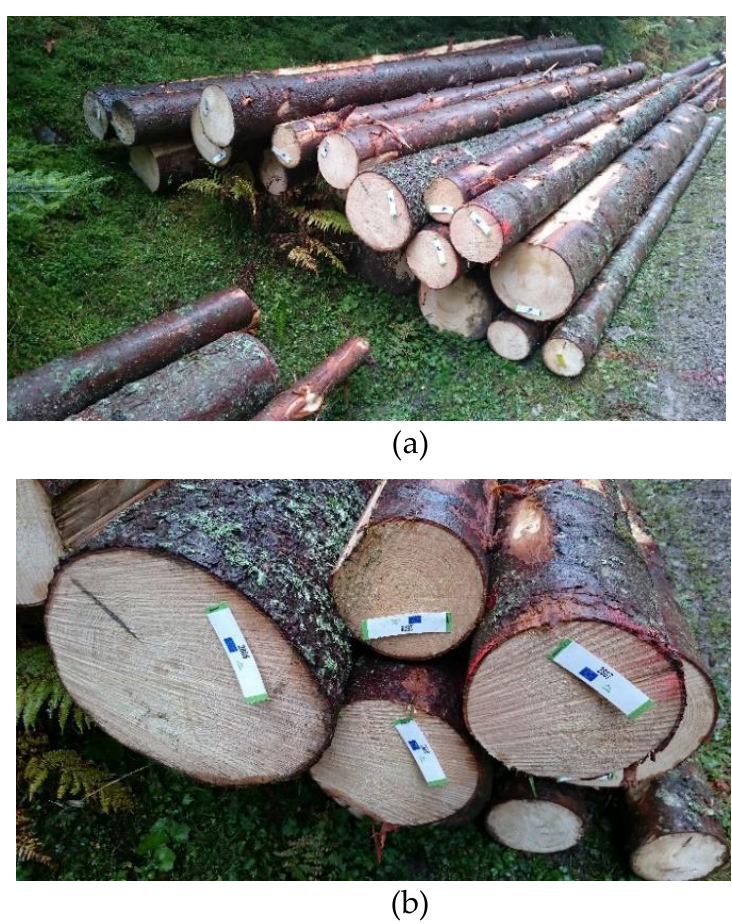
Figure 7. Timber pile (a) and logs with new RFID tags on the butt end (b).